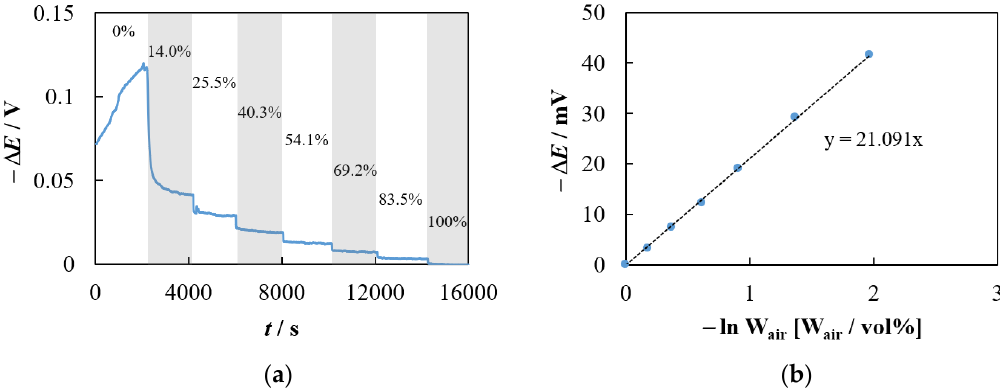
Figure 2. ( a ) Experimental time dependence of the potential difference between two platinum–oxygen electrodes with a stepwise change in the volume fraction of air, W air , above one of them. The W air (vol%) values are shown in the figure. T = 983 K. Other details of the experiment are described in Section 2.2.1. ( b ) Dependence of the potential difference on the logarithm of the volume fraction of air.